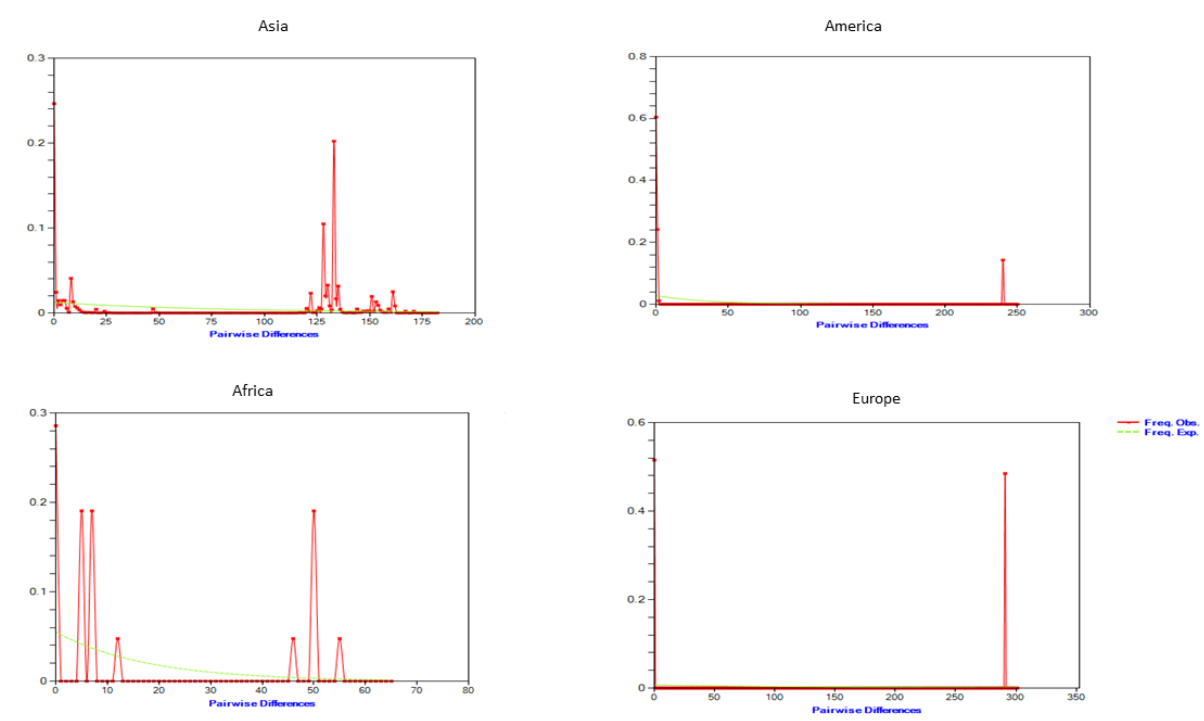
Figure 3. Mismatch distribution relevant to geographic and haplotypic groups of B. sorokiniana . The observed frequency of pairwise differences (solid line) iscompared against the expected frequencies under expanding population size (dotted line), whereas figures in the clockwise direction represent- mismatch distribution across the continents of Africa, America, Asia, and Europe, respectively.